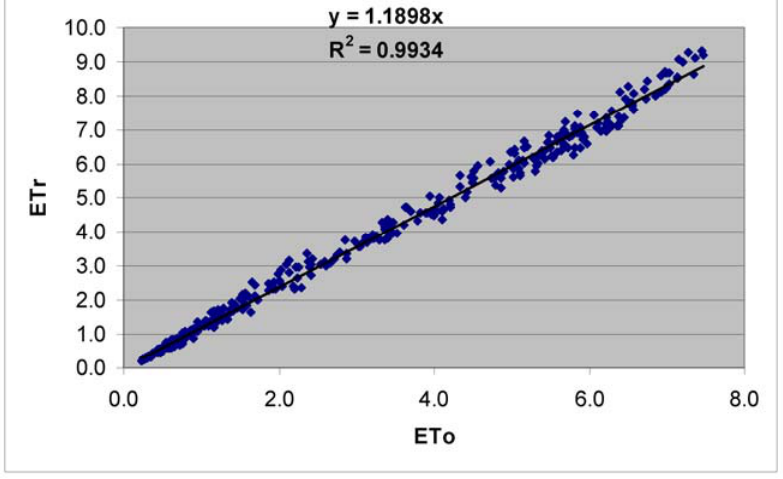
Figure 11. Alfalfa (ETr) versus grass (ETo) reference ET relationship.